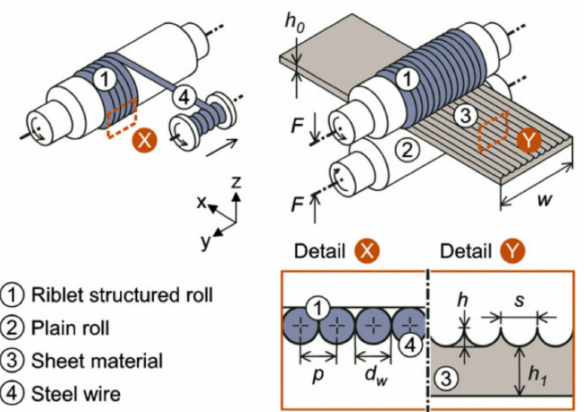
Figure 14. Schematic illustration of riblet rolling, reproduced from [52], with permission from Elsevier,